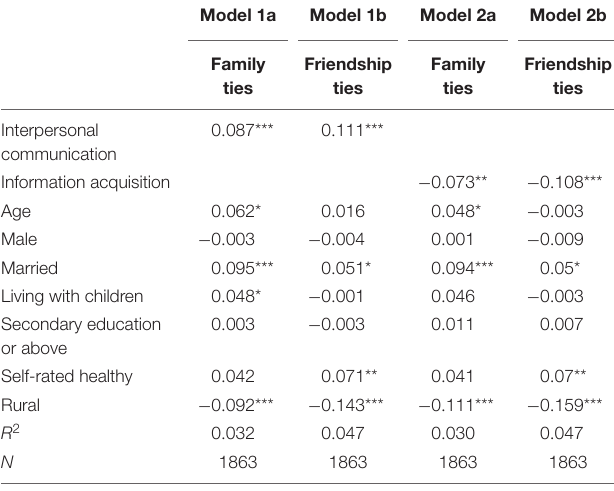
TABLE 2 | Social networks regressed on Internet use ( β ).